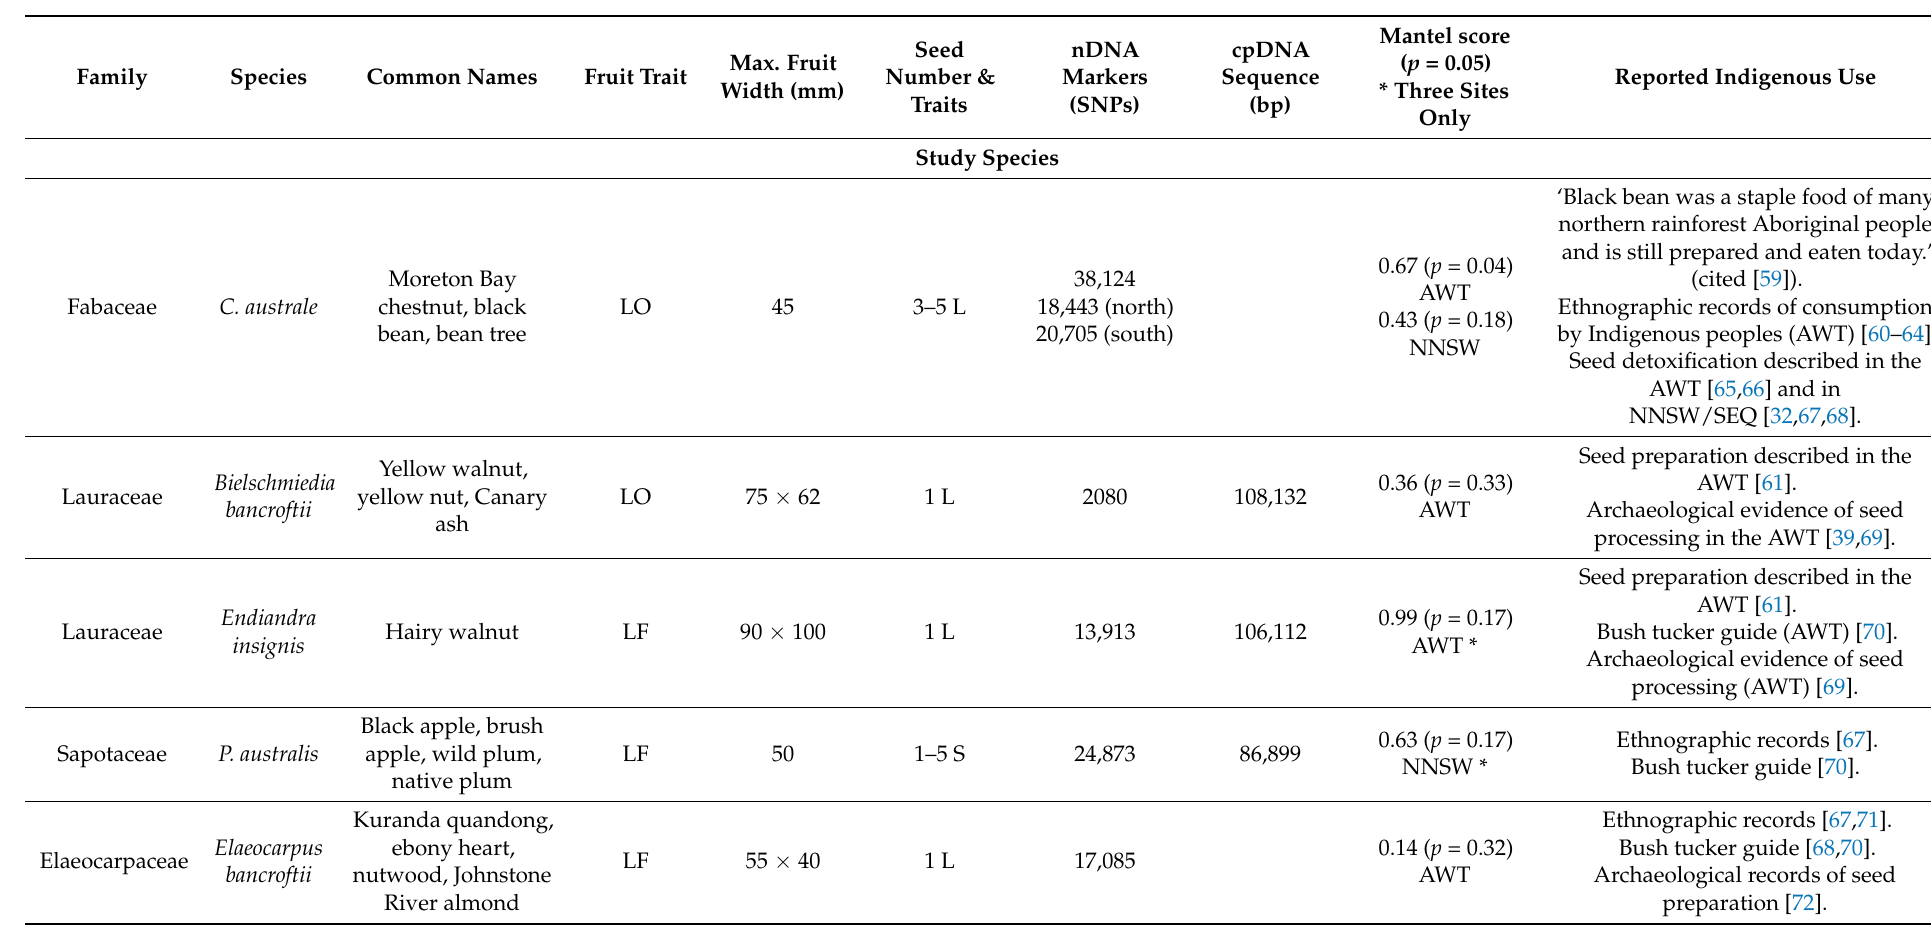
Table 2. The study species and their fruit traits, the genomic data used in the study and references that report use of each species by Indigenous Australians. Fruit traits: S = Small (<30 mm), L = Large (>30 mm), F = Fleshy, W = Woody, O = Other. Seed traits: L = Large, S = Small. nDNA = nuclear DNA. cpDNA =